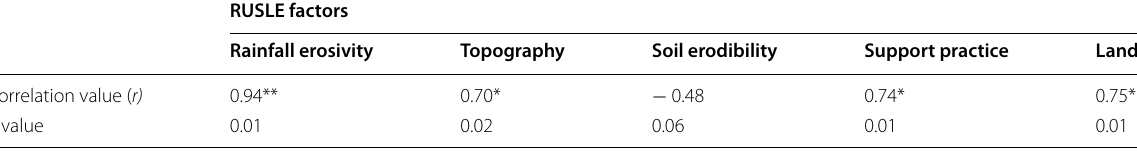
* Correlation is significant at the 0.05 level (two-tailed)